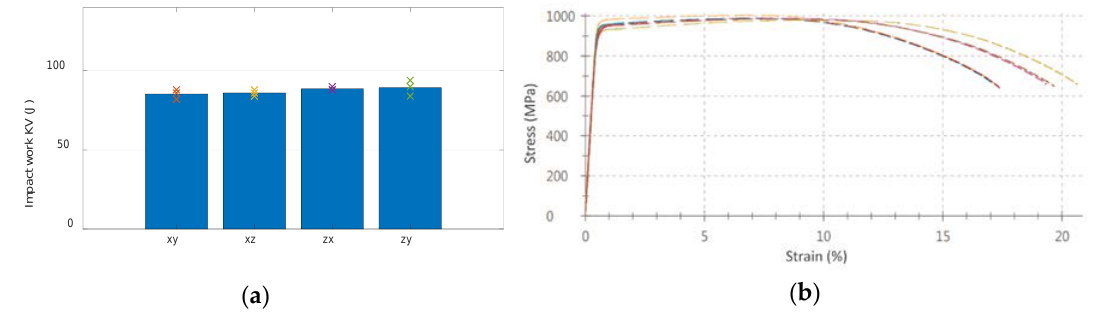
Figure 9. Results for the mechanical testing: ( a ) impact energy; ( b ) stress strain curve.